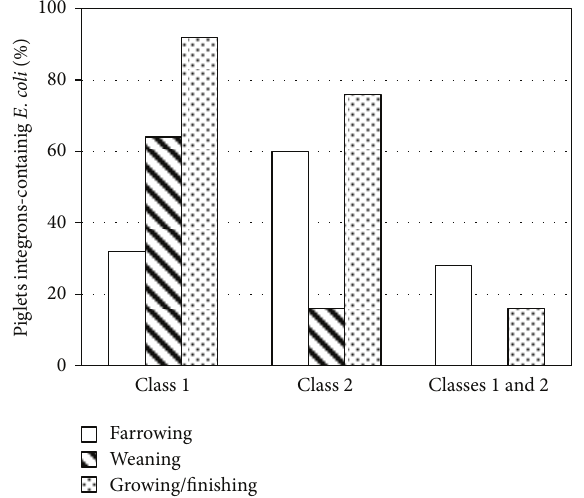
Figure 2: Percentages of integron positive piglets at different stages of production.